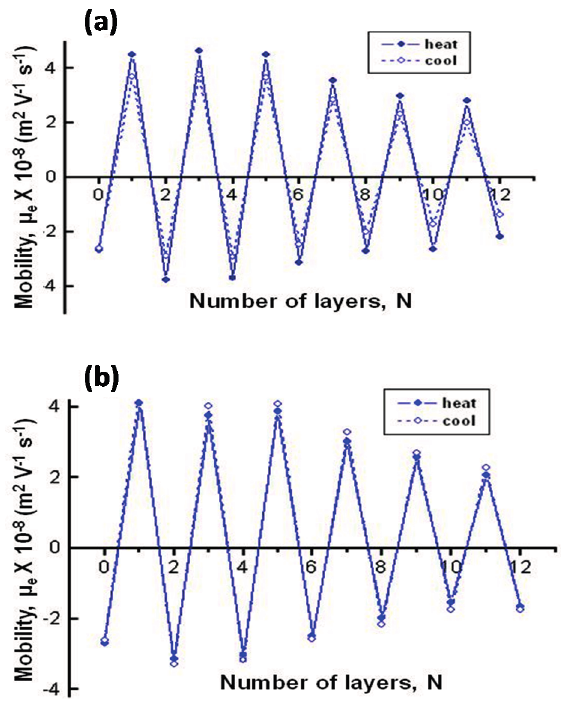
Figure 5. Electrophoretic mobility μ e at 20 °C vs. number of layers deposited on PNiPAM- co -MAA NGs: ( a ) NG/(PLL/PGA) and ( b ) NG/(CHIT/DEXS). Reproduced with permission from [8], copyright 2010,